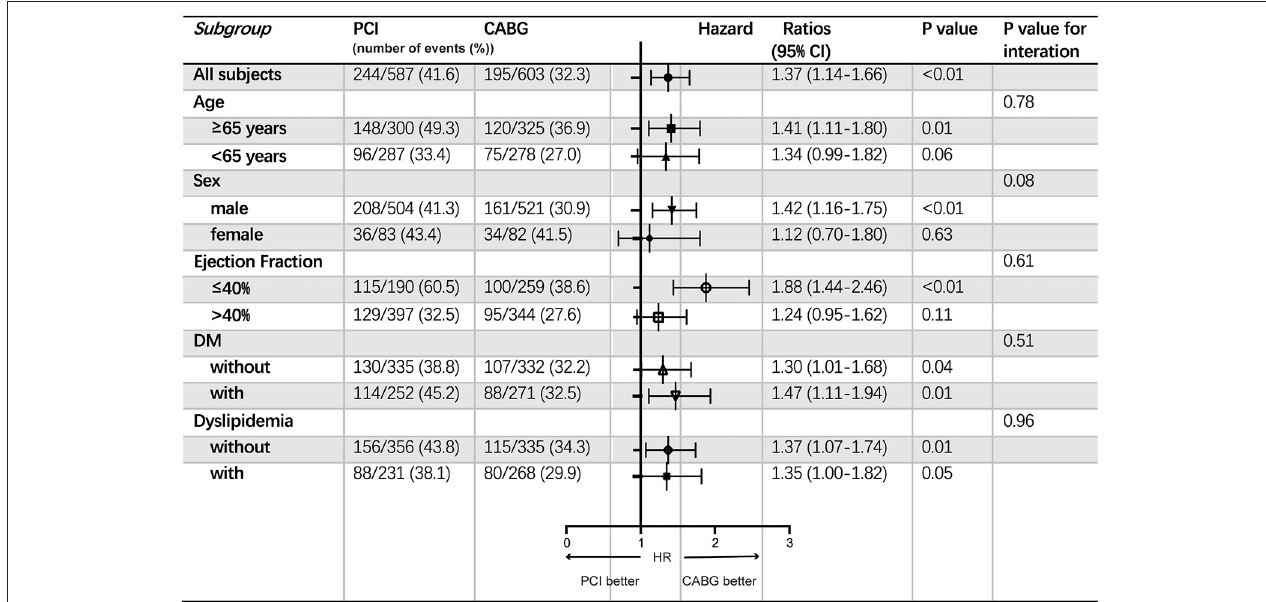
FIGURE 3 | Subgroup analyses of the primary endpoint. Event rates and hazard ratios with 95% confidence intervals are shown for the primary endpoint in all patients stratified into different subgroups according to age, sex, ejection fraction and comorbidities including DM and dyslipidemia. CABG, coronary artery bypasses grafting; CI, confidence interval; DM, diabetes mellitus; HR, hazard ratio; PCI, percutaneous coronary